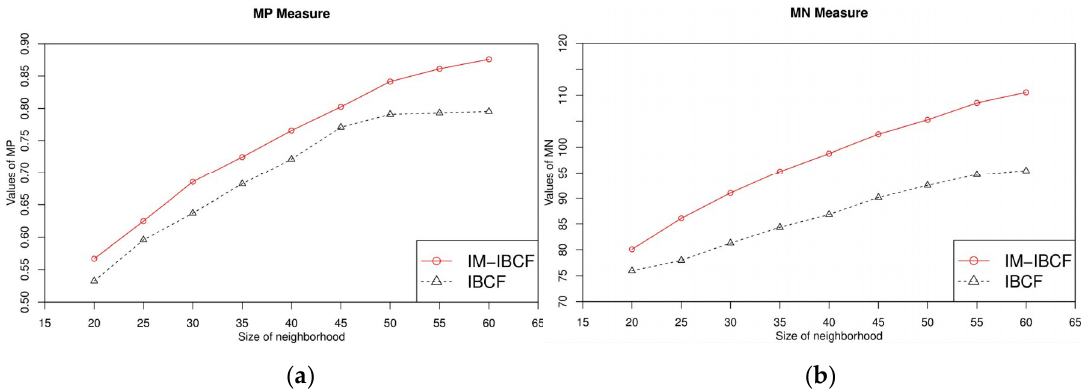
Figure 2. MP ( a ) and MN ( b ) results with MovieLens 100K dataset.